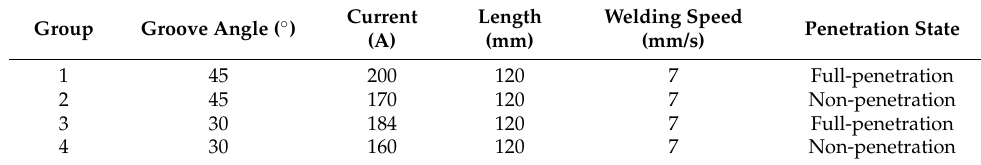
Table 1. Experimental parameters.